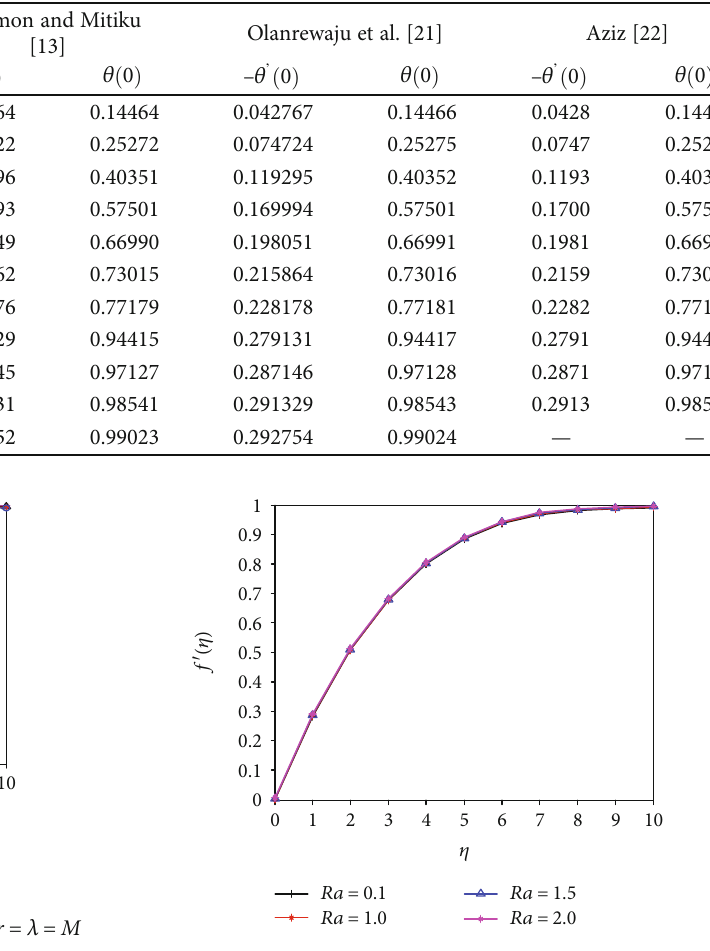
Figure 2: Velocity pro fi les for unlike values of Ra once Pr = 0 : 72 , Gr = 0 : 1 , M = 0 : 1 , λ = 0 : 1 , and Bi = 0 : 1